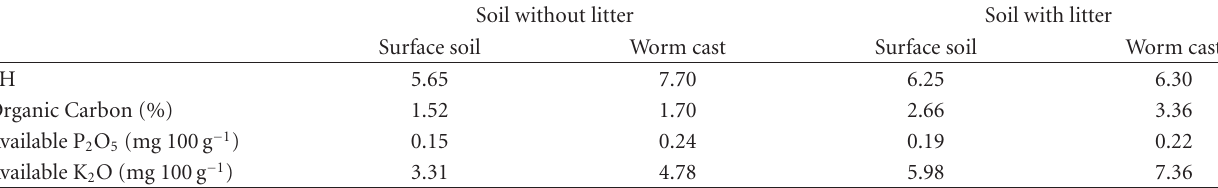
Table 1: Some properties of casts of Pheretima alaxandri and their underlying soils with and without litter cover [10].